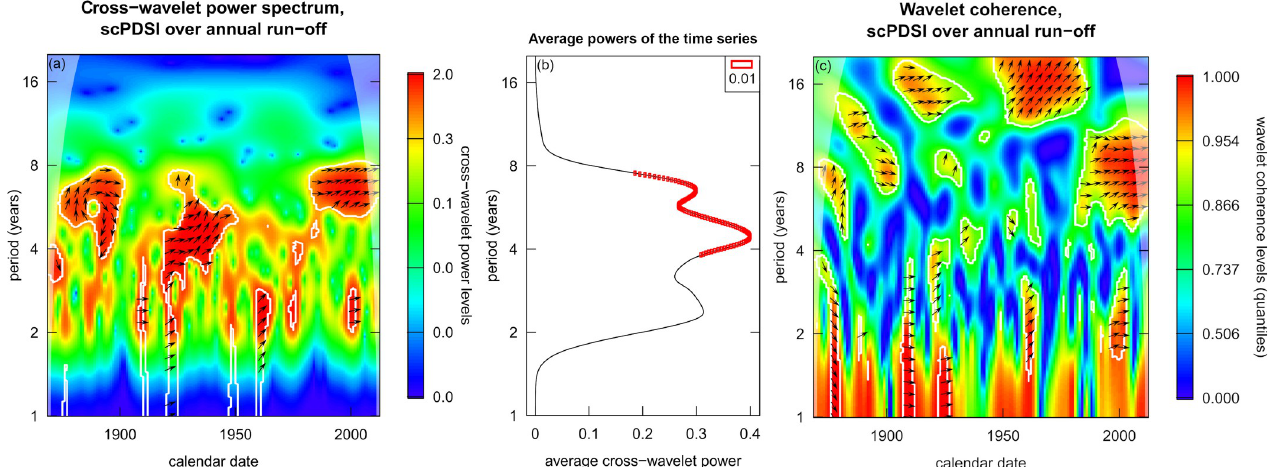
Fig 6. Plot of the wavelet analysis power spectrum (a), average powers of the time series (b), and coherence (c) for annual run-off at Basel and mean PDSI in the catchment over the period 1869–2012. Time-averaged cross-wavelet power plot with significance level of 1% (p-value 0.01); power spectrum window.size.s = ¼ , coherence window.size.s = 1; nsim =